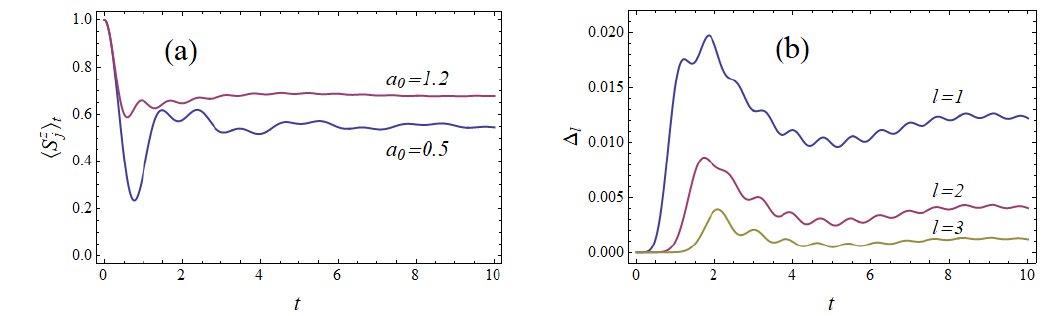
〉 Figure 2: (a) 〈 S z in the superintegrable chiral 3-state Potts model calculated via eq. t j = 4. The initial state is the product translation- (31) with the sum truncated at l max invariant state (28) with all spins polarized along the z -direction. The calculation = − 1 and two values of a is done for a shown in the plot. (b) Illustration of the 1 0 convergence of the series in eq. (31). Plotted is the difference ∆ 〉 approximations to 〈 S z derived from the truncated eq. (31), with truncation orders t j = l and l = 4, respectively. The parameters of the Hamiltonian are equal to l max max = 1.2 and a = − 1. One can see that truncation error is small already for l a 0 1 and rapidly vanishes with growing l max